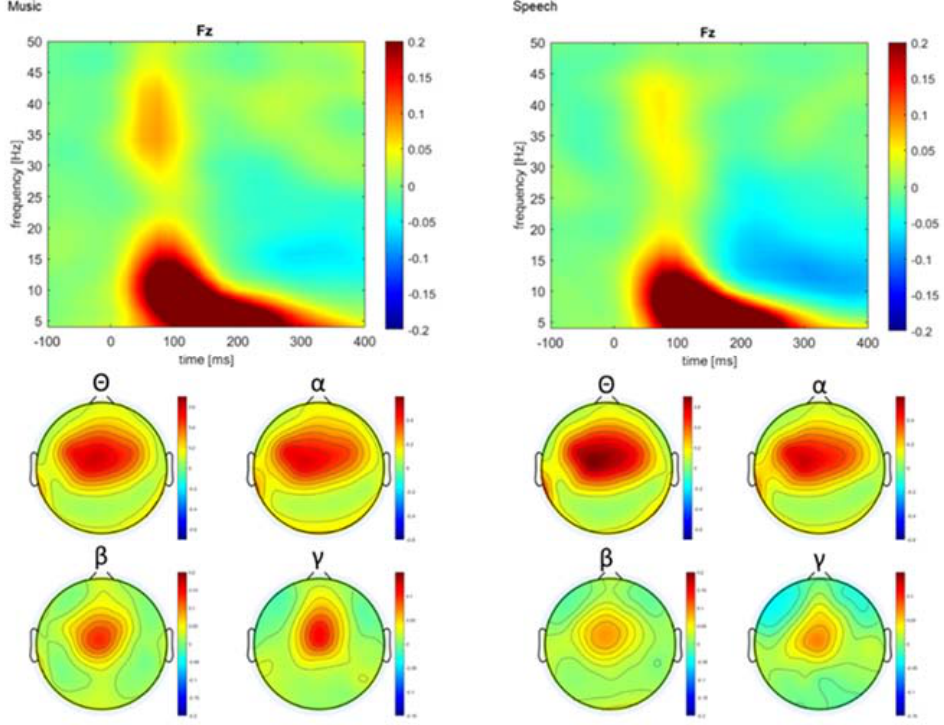
Figure 3. Pooled group mean power temporal spectral evolution (TSE) elicited by standard stimuli at the midline frontal electrode (Fz), and the corresponding scalp distribution for theta ( θ ), alpha ( α ), beta ( β ), and gamma ( γ ) power at 150 ms, 100 ms, 100 ms, and 75 ms post-stimulus, respectively.